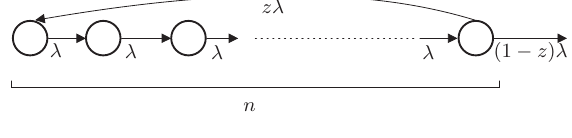
Figure 1: FE-diagonal block.